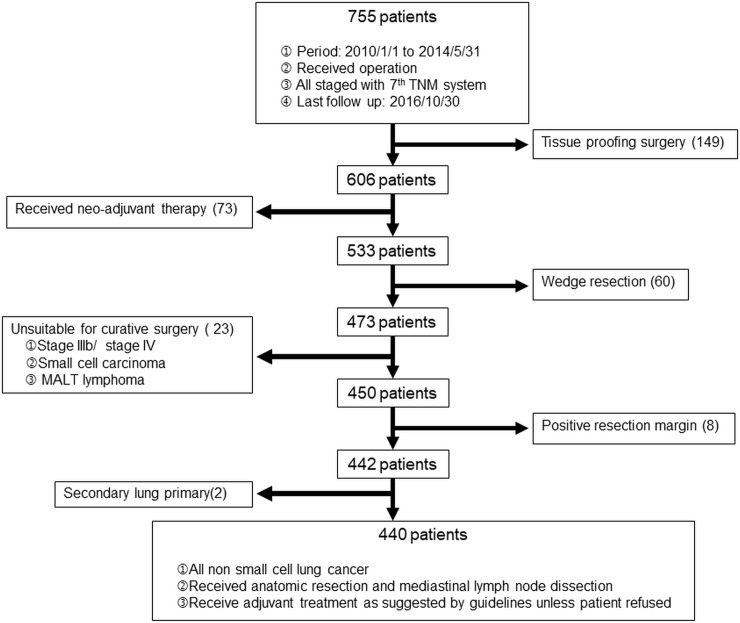
Exclusion algorithm.